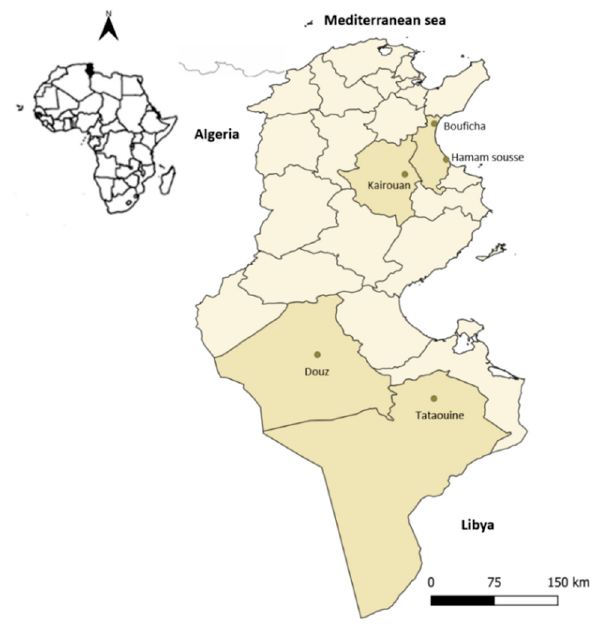
Figure 2. Map of Tunisia showing the visited governorates.